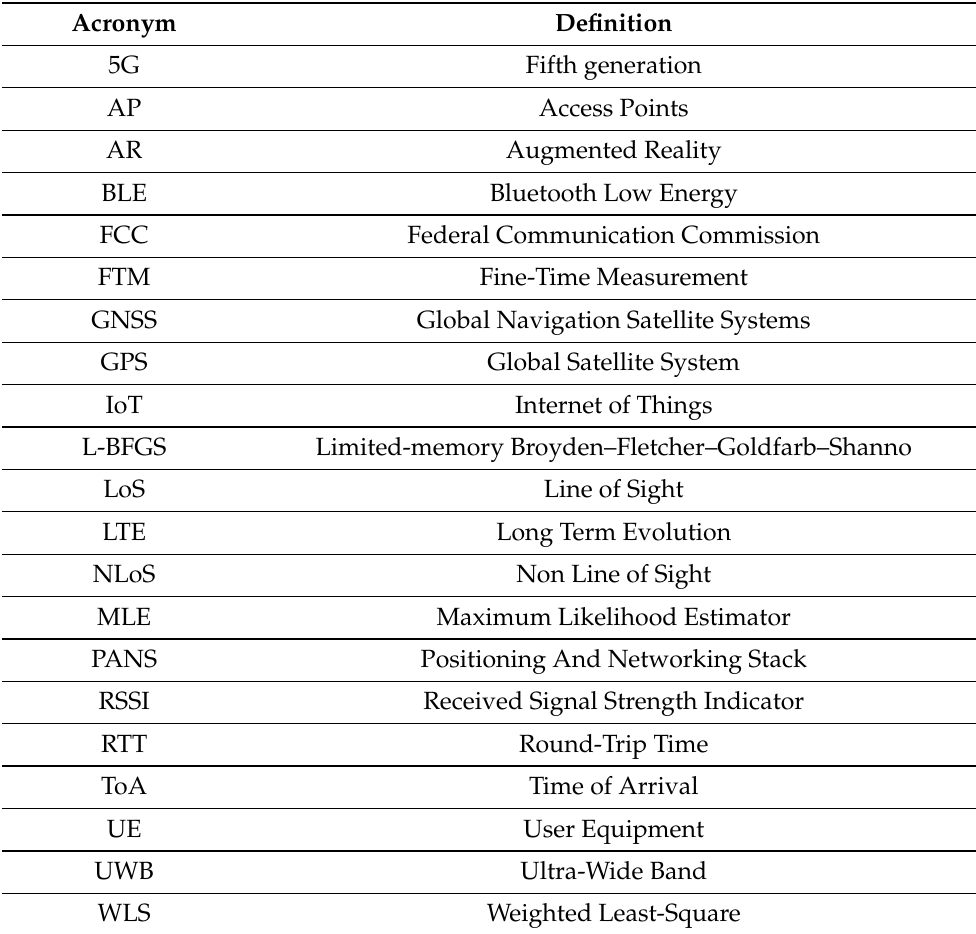
Table 1. Overview of